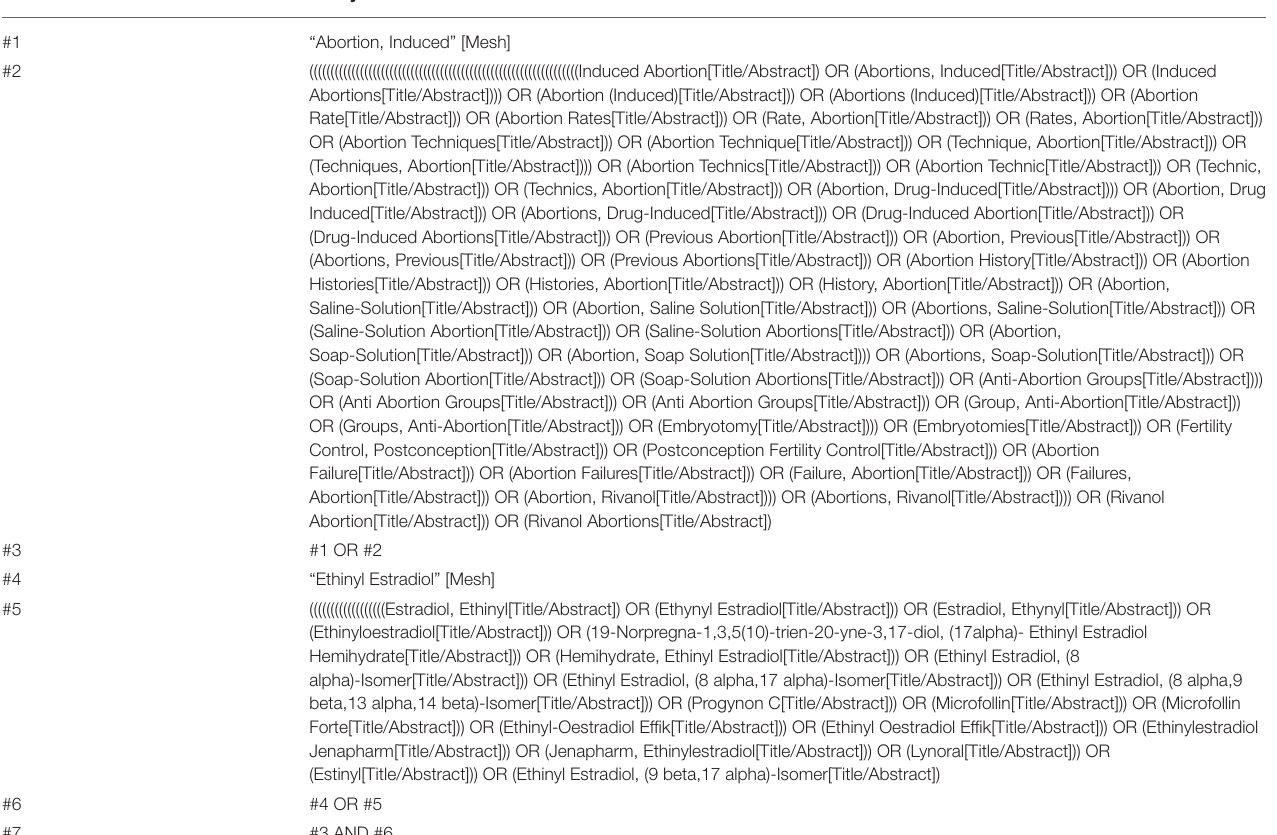
TABLE 1 | PubMed retrieval